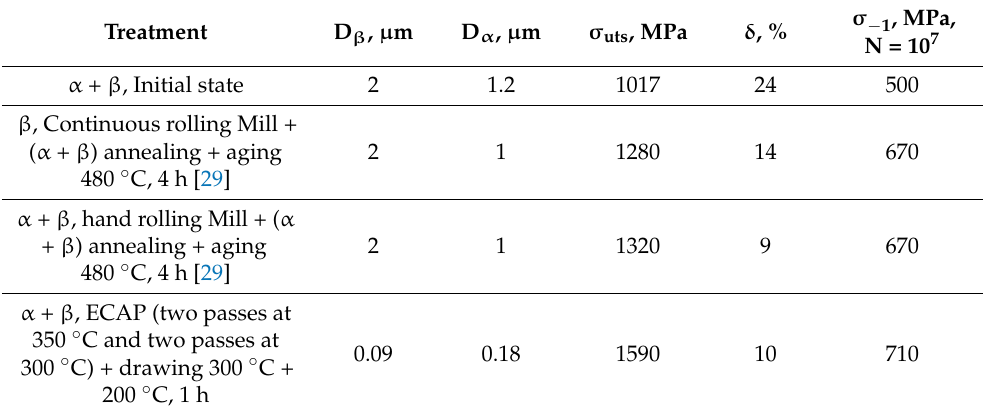
Table 2. Microstructure parameters and mechanical properties of the Ti-15Mo alloy after combined deformation treatment, including ECAP-C and drawing and conventional treatments